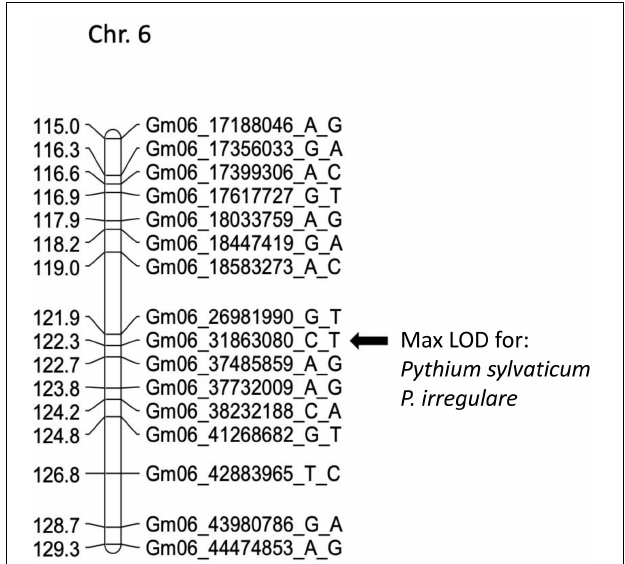
FIGURE 2 | Schematic representation of a regional linkage map of chromosome 6 for POP4 with the map position for the QDRL for resistance to Pythium sylvaticum and P. irregulare highlighted. The SNP markers are identified on the right side and cM distances are on the left side. The closest SNP marker to the QDRL is shown by an